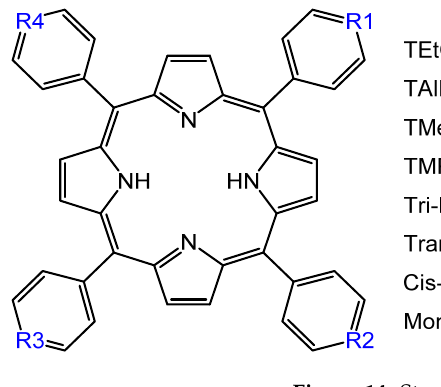
Figure 14. Structures of the P&A [93].